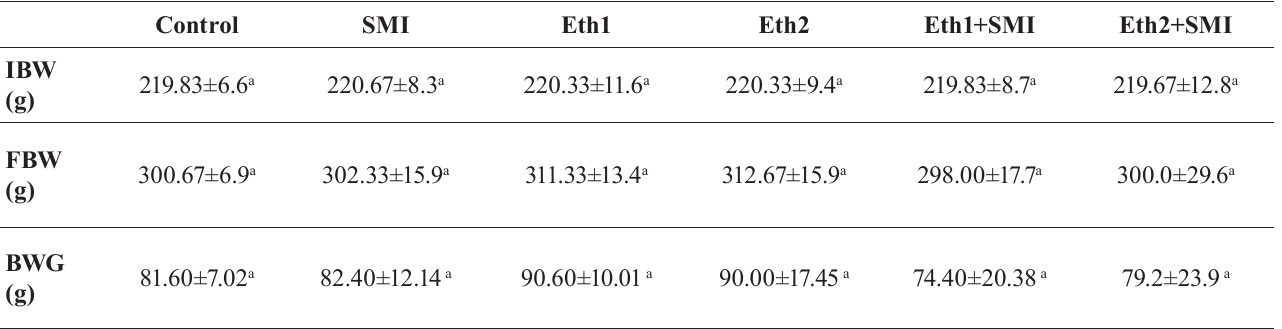
TABLE I - V alues of body weight (g) (initial body weight, final body weight and body weight gain) of Wistar rat expressed as mean ± SD after six consecutive weeks of treatment Control SMI Eth1 Eth2 Eth1+SMI Eth2+SMI